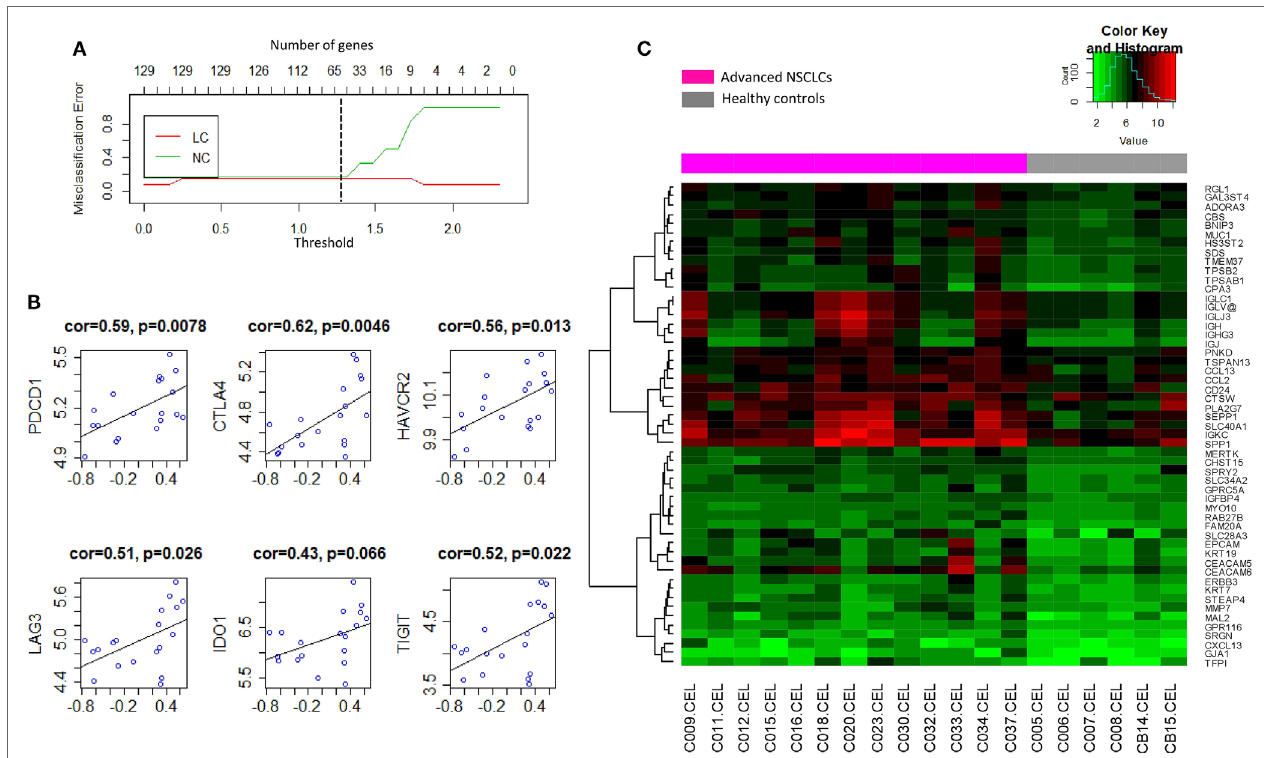
FigUre 5 | (a) Shrunken centroid method coupled with 10-fold cross-validation for determining the optimal number of genes for the signature model. A shrunken threshold of 1.25 corresponding to the reduction of 62 genes (black broken line) preserved the lowest error rate. (B) Correlation analysis of the signature of bronchoalveolar lavage (BAL) cells ( X -axis) with the gene expression levels of checkpoint proteins programmed cell death 1/ PDCD1 , CTLA4 , TIM-3/ HAVCR2 , LAG3 , IDO1 , and TIGIT . (c) Heat map visualization of the global expression for the 53 upregulated genes of BAL cells in the discovery